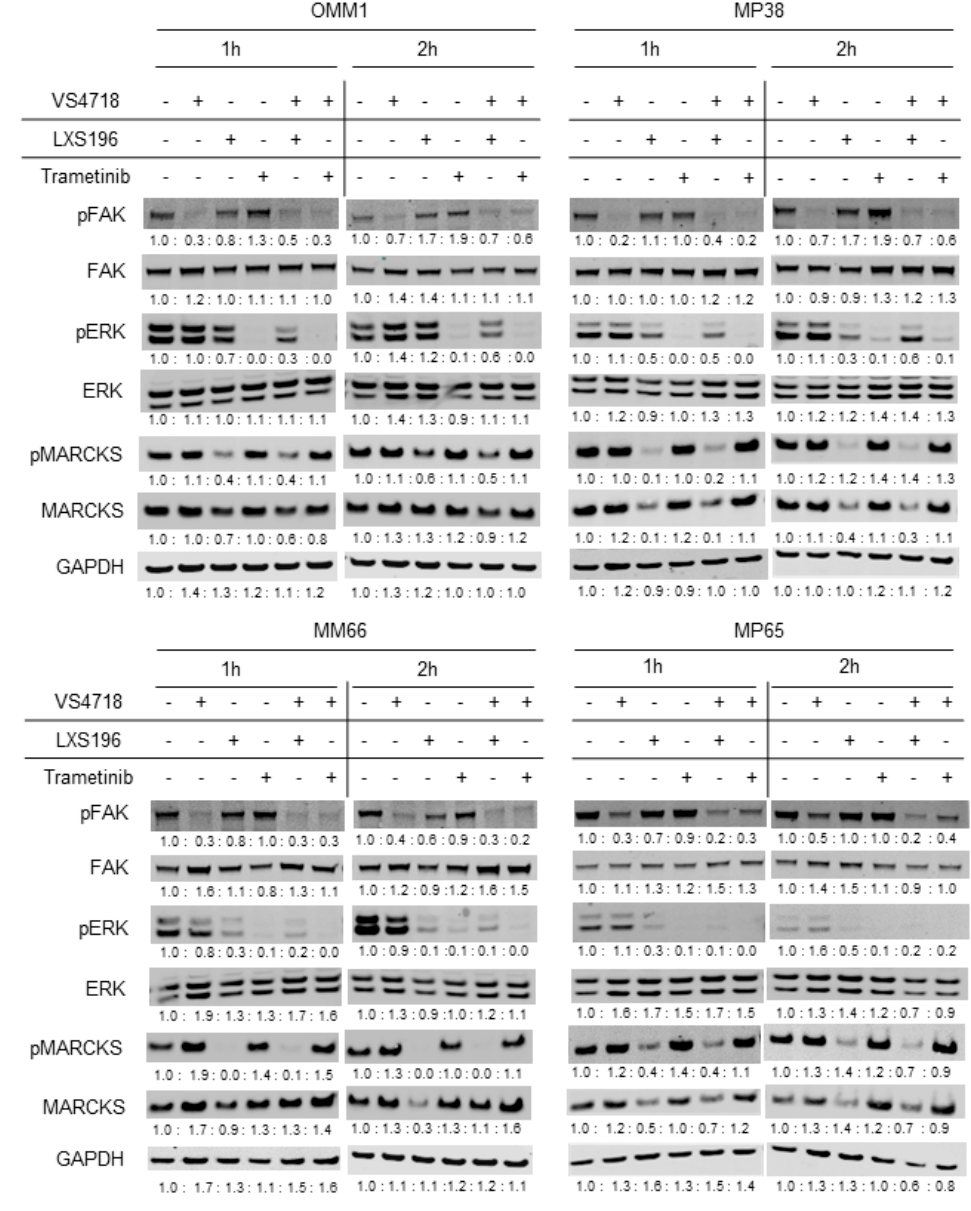
Figure 3. Immunoblot analysis for key signaling pathways in uveal melanoma. Immunoblotting of